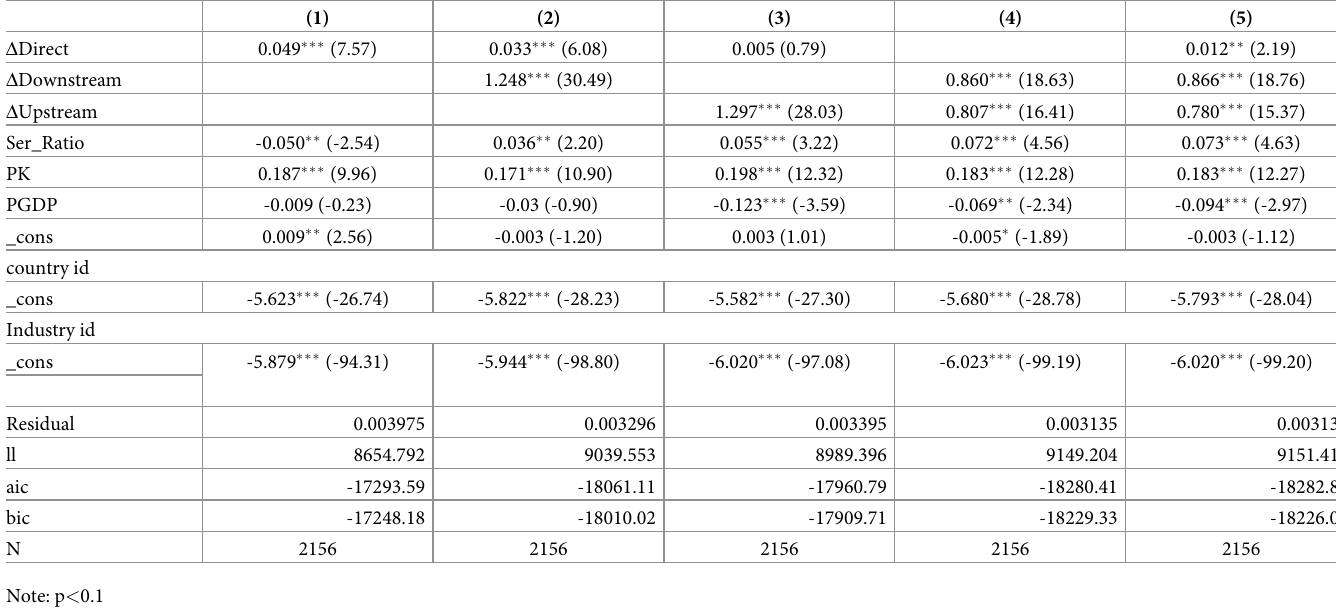
Table 2. Maximum likelihood regression results of benchmark